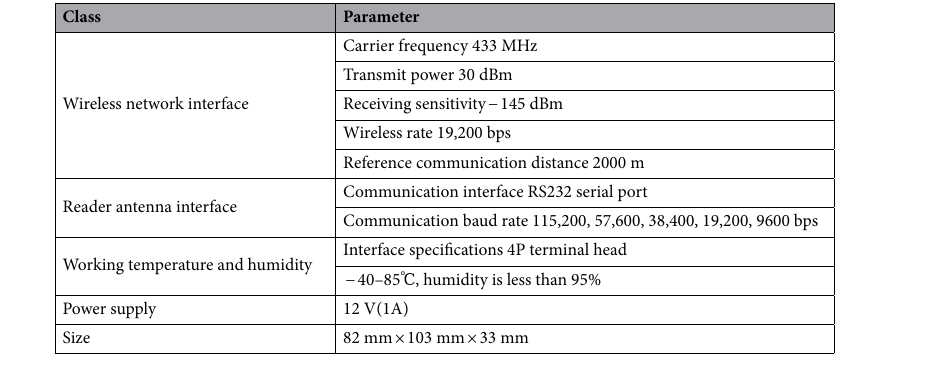
Table 2. Technical